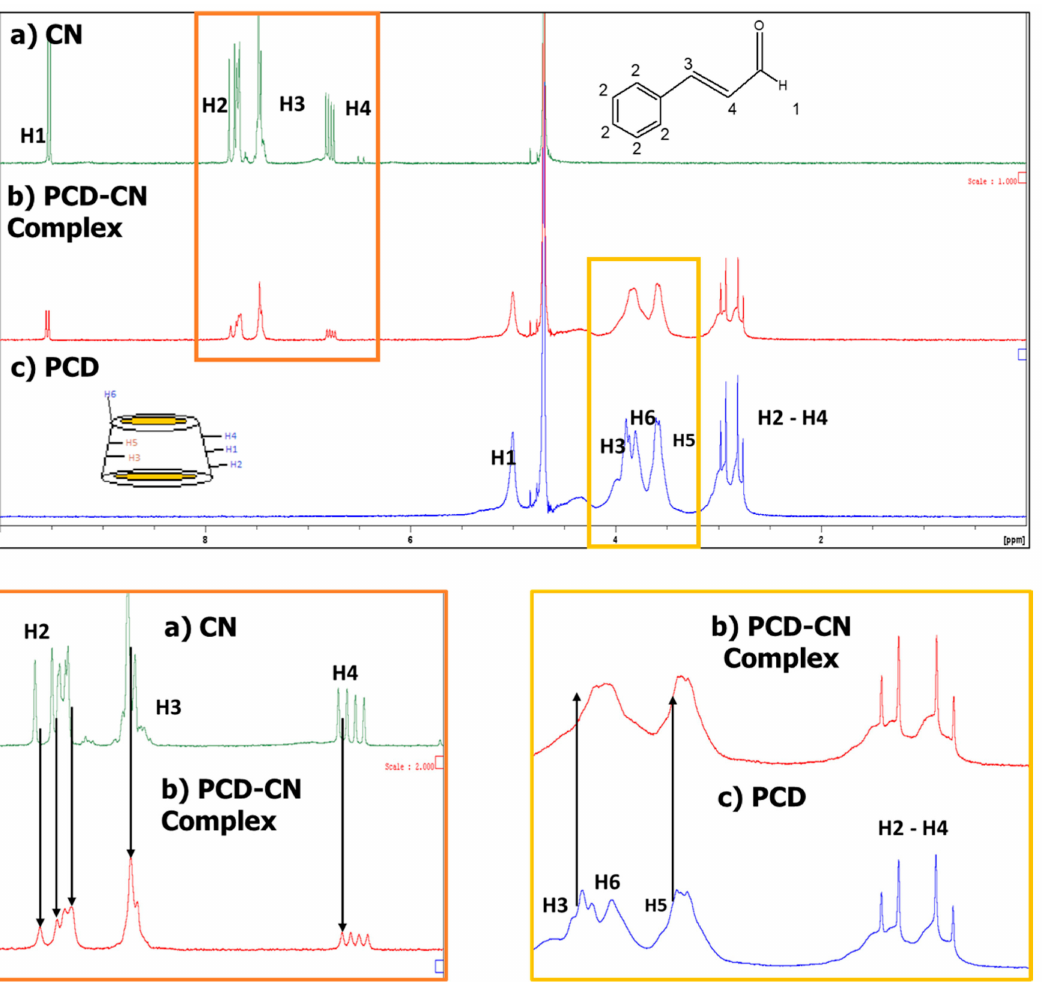
Figure 1. H 1 NMR spectra of PCD ( c ), PCD:CN complex ( b ), and CN ( a ). A zoom of PCD H3 and H5 proton shifts in the complex spectra compared to PCD spectra is shown in a yellow square. Additionally, a zoom of the H2 (aromatic protons), H3, and H4 shifts from the PCD:CN complex spectra is shown in an orange